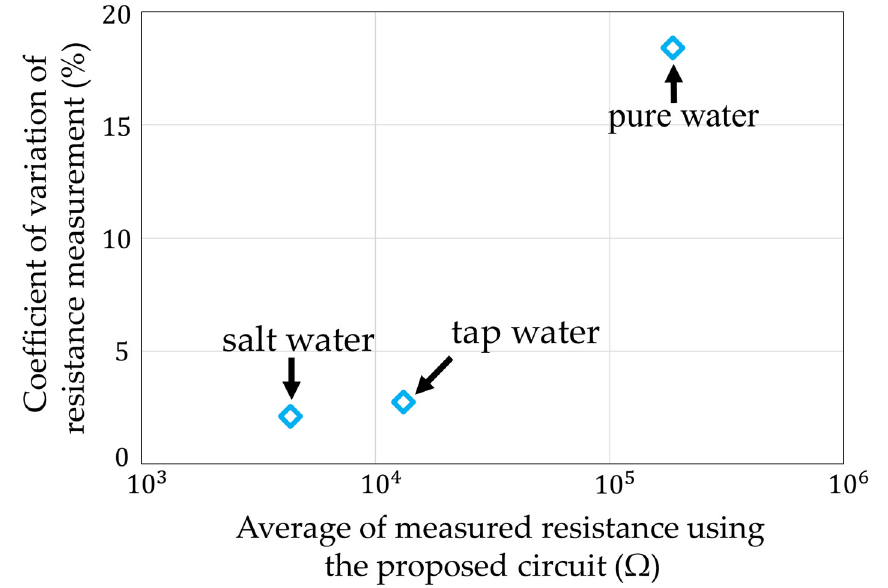
Figure 23. Coefficient of variation of Figure 21.